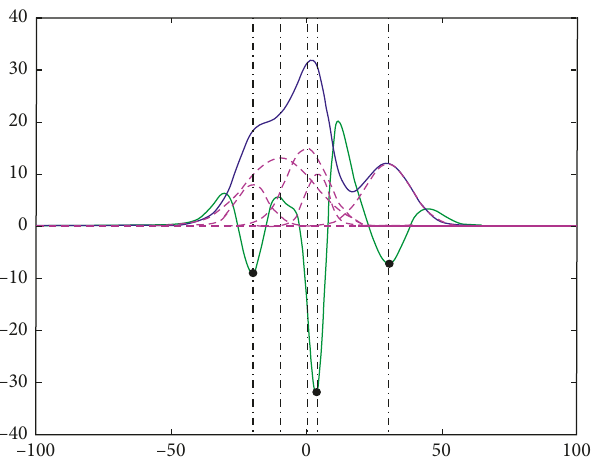
Figure 16: Location of peaks by the second derivative method on a bone spectrum between 900 and 1200cm − 1 . The approximate position of peaks is marked in dashed-black lines. A peak is not detected by this method, and another one is created on the left part of the spectrum.